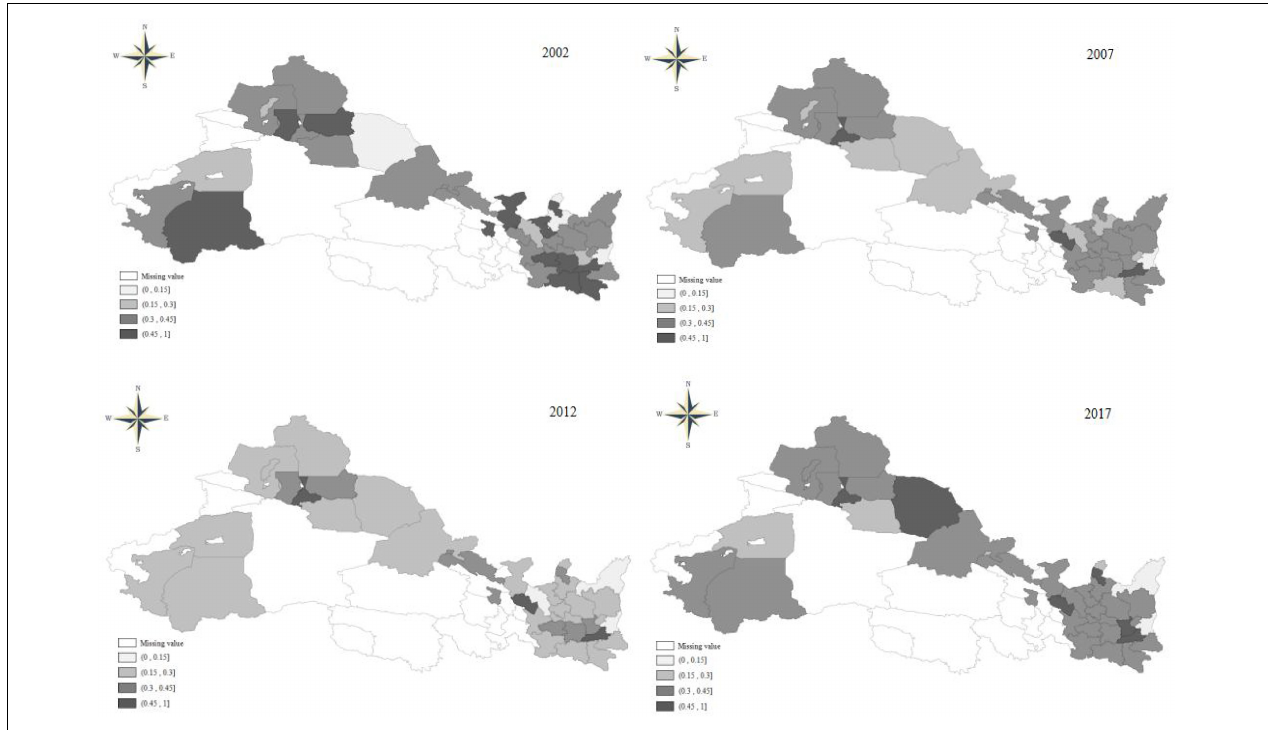
FIGURE 3 | Spatial evolution of the W-E-F-E nexus in Northwest China.